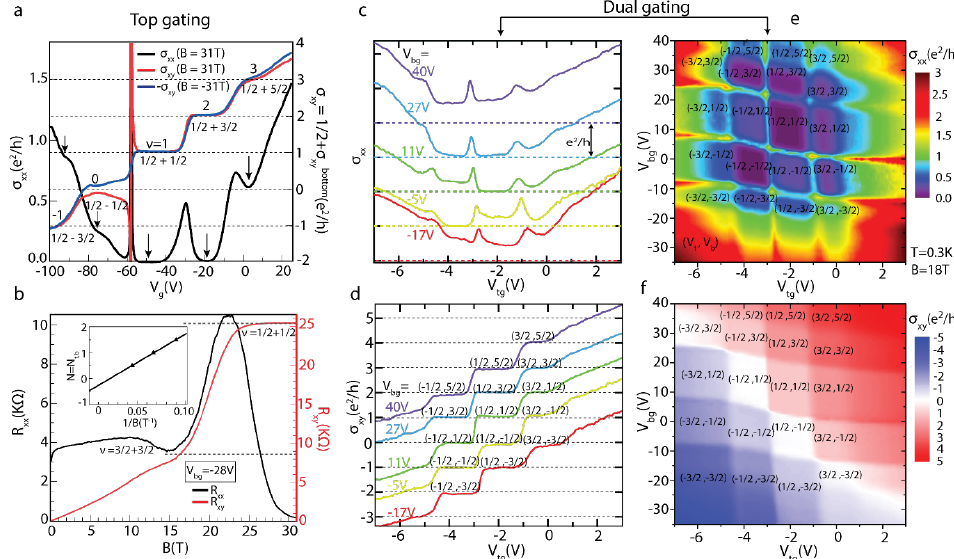
Figure 2: QHE in flakes of TI single crystals . a, Gate voltage ( V ) dependence of g the 2D longitudinal conductivity ( σ ) and Hall conductivity ( σ ) for a back-gated xx xy / Si substrate and at magnetic field 31T. 160-nm-thick exfoliated BSTS flake on SiO 2 This experiment is the first-time observation of QHE in a TI system. ν e 2 / h plateaux observed in σ are marked with the corresponding top surface ( ν ) + bottom sur- xy top face ( ν ) Landau filling factors of the quantum Hall states. Arrows show the cor- bot = responding σ minima. b, Magnetic field dependence of R and R measured at V xx xx xy g − 28 V and at 350 mK on a different sample with the same thickness. R shows xy clear ν = 1 plateau (accompanied by an almost vanishing R ) and an almost ν = xx 3 plateau (accompanied by an R minimum). The inset shows the LL fan diagram xx with 1 / 2-intercept in LL index, which is a hallmark of Dirac fermions and underlies the half-integerQHE. Figures (a) and (b) are adapted from ref. [ 68 ] c, σ and d, xx 2 σ steps for clarity) as functions of V and for 5 different (shifted vertically by e xy tg h values of V at magnetic field 18 T and at 300 mK in a ∼ 100 nm-thick exfoliated bg / Si substrate for bottom-gate and with 40 nm-thick h-BN as a BSTS flake on an SiO 2 top-gate dielectric, which features a series of ambipolar two-component half-integer Dirac quantum Hall states. Quantum Hall states are labelled by the corresponding (top, bottom) surface filling factors. e, 2D color maps of σ (top panel) and (bottom xx panel) as functions of V and V at 18 T and 300 mK. Figures (c), (d), and (e) are tg bg adapted from ref. [ 70